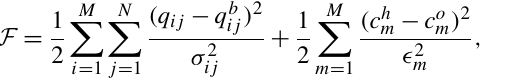
Figure 1. Distribution of the 84 measurement sites and two CAP- TEX source locations (Dayton, Ohio, USA, shown as a red dia- mond, and Sudbury, Ontario, Canada, shown as a green